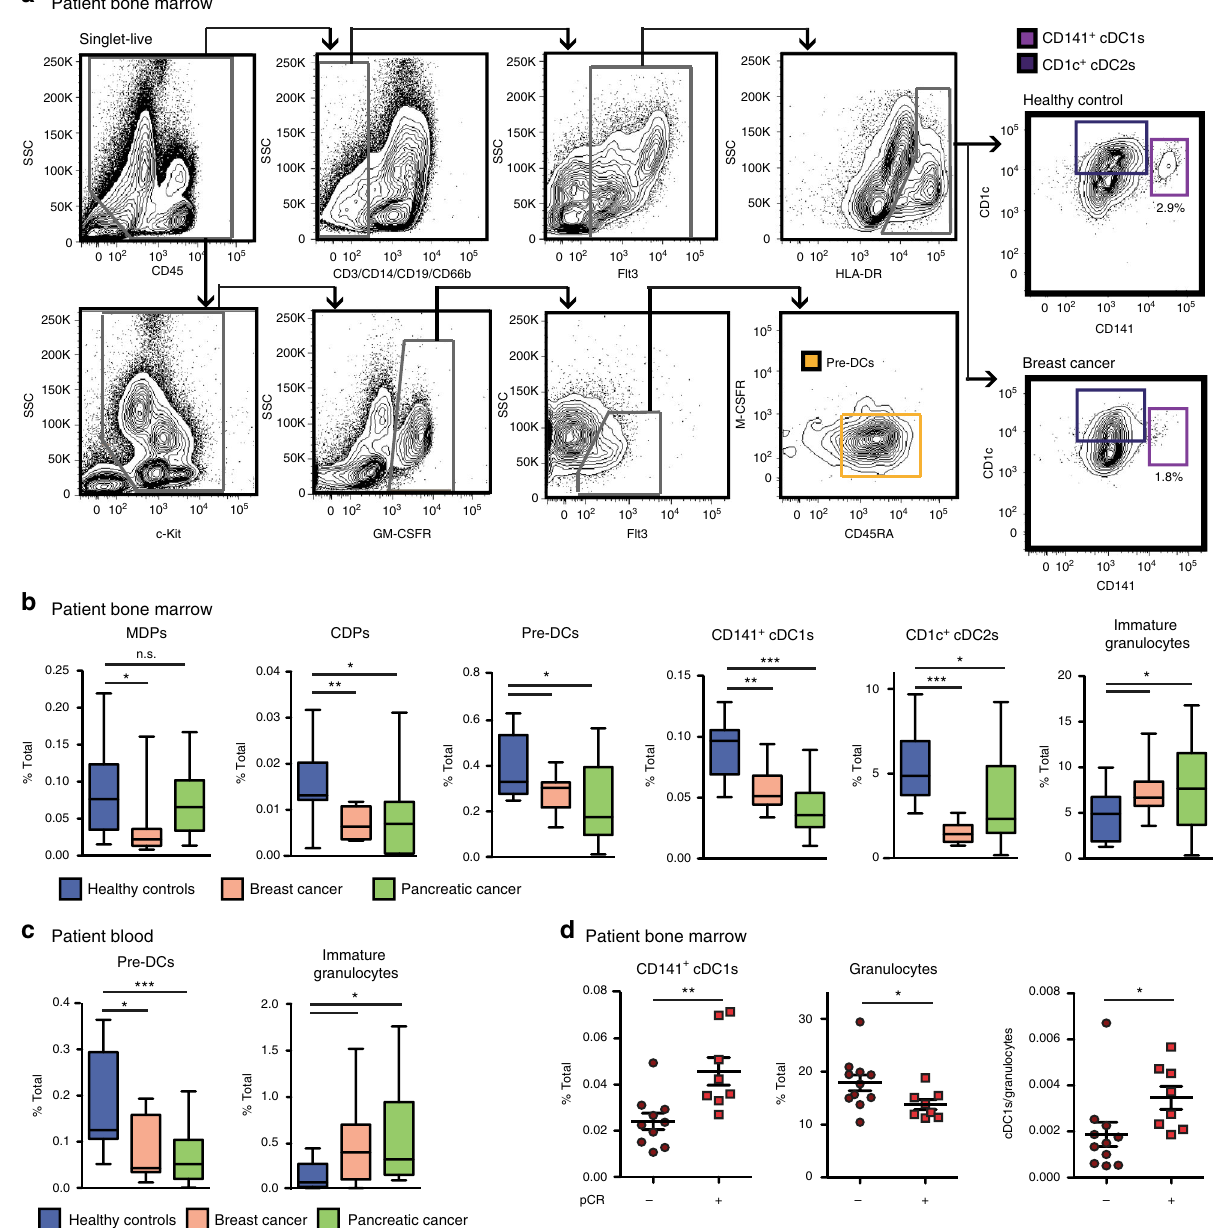
Fig. 1 Human breast and pancreatic cancers reduce dendritic cell progenitors and CD141 + cDC1s. a Representative fl ow cytometry gating strategy for human BM pre-DCs, CD141 + cDC1s, and CD1c + cDC2s, including representative fi nal plots from a BC patient and from a healthy control. b Frequency of BM MDPs, CDPs, pre-DCs, CD141 + cDC1s, CD1c + cDC2s, and immature granulocytes (CD11b + CD33 High CD14 - CD15 + ) in baseline BC and PDAC patients relative to healthy controls. Data from BC cohort 1 and PDAC cohort 1. Healthy controls n = 12; BC n = 10; PDAC n = 19. c Frequency of circulating blood pre-DCs and immature granulocytes in baseline BC and PDAC patients relative to healthy controls. Data are from BC cohort 1 and PDAC cohort 1. Healthy controls n = 12; BC n = 10; PDAC n = 17. d Frequency of BM CD141 + cDC1s and granulocytes (CD45 + CD11b + CSF1R − CD15 + CD14 − ), and the ratio of cDC1s/granulocytes in BC patients prior to treatment or surgical intervention comparing those who achieved pathological complete response relative to patients who did not achieve pathological complete response in BC cohort 2; n = 18. Additional cohorts illustrated in Supplementary Figure 1. Error bars represent mean + / − s.e.m. or box plot; * p < 0.05, ** p < 0.01, *** p < 0.001, n.s., not signi fi cant by unpaired two-sided Student ’ s t